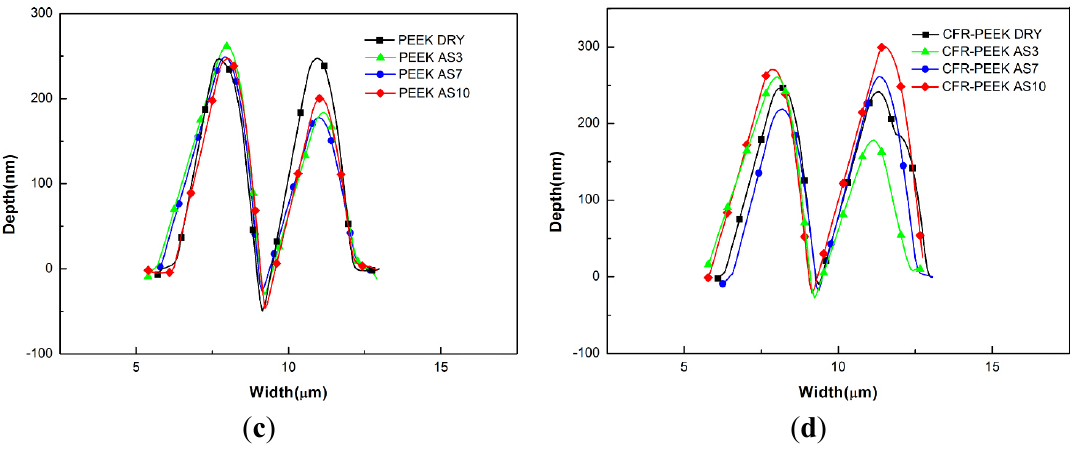
Figure 7. Residual scratch profiles of the ( a ) CHARISMA, ( b ) PMMA, ( c ) PEEK, and ( d )